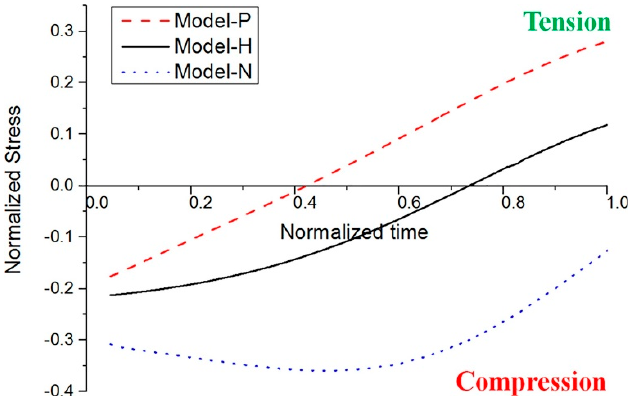
Figure 20. Evolution of stress state at the bottom of graded and homogenous porous coatings in the graded temperature field [140] .